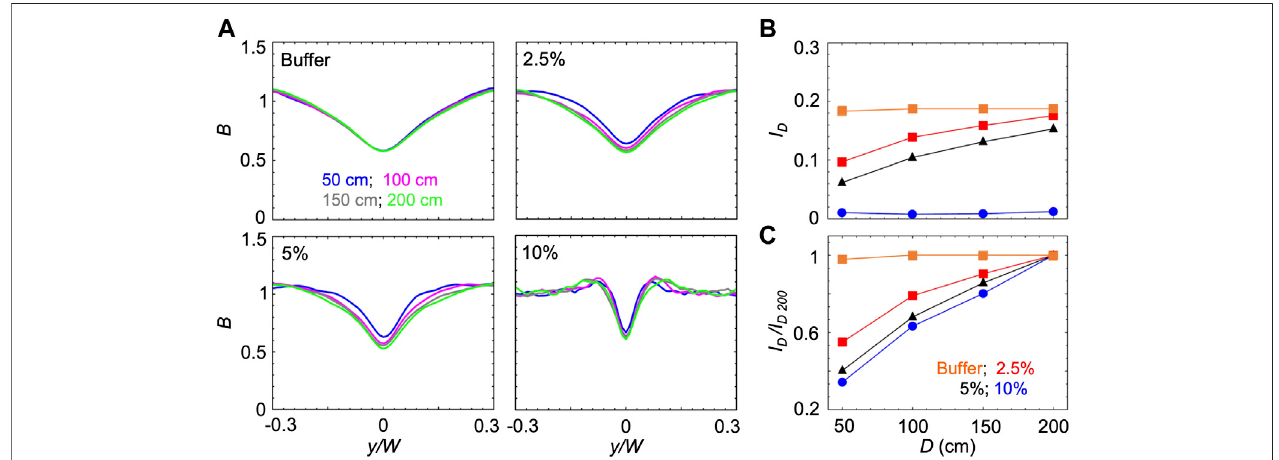
FIGURE 4 | (A) Bacterial concentration pro fi les B numerically calculated according to the mathematical model for mean shear rate S = 10 s − 1 in buffer (upper left) and in PVP 360 solutions at 2.5 w/v% (upper right), 5 w/v% (lower left) and 10 w/v% (lower right). For each fl uid, the pro fi les were computed at a distance D of 50 cm (blue),100 cm(pink),150 cm(grey)and200 cm(green)fromtheinlet. (B) Thedepletionindex I D asafunctionofthedistancefromtheinlet D inbuffer(orange)andinPVP 360solutionsat2.5w/v%(red), 5w/v%(blue) and10w/v%(black)measured from thenumericalbacterialconcentrationpro fi les shown in (A) . (C) Depletionindex normalized by the depletion index at D = 200 cm, I D /I D 200 , as a function of the distance from the inlet D , calculated from the curves shown in